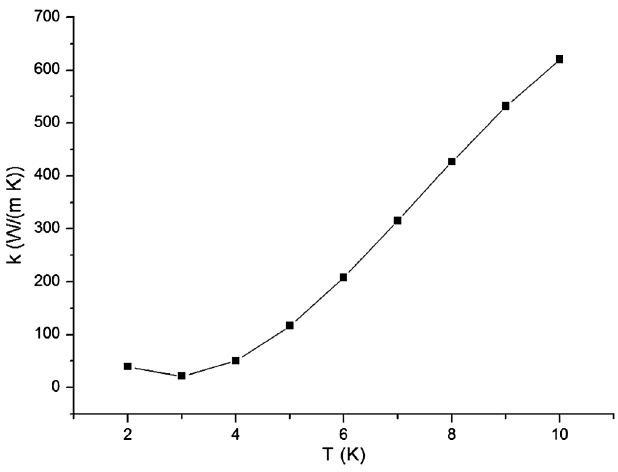
FIG. 6. Thermal conductivity of niobium ( RRR ¼ 250 ).